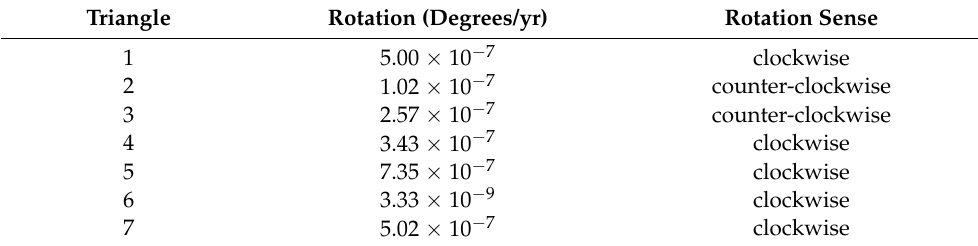
Figure 16. The post-Neogene stress and strain map of the north part of the East Iran orogen (EIO). The present-day stress and strain directions are from the stress inversion of the fault data and geodetic data, respectively. The paleo-stress data are based on [6], and the presented stress inversions of the focal mechanism (FMSI) are from [60]. The geodetic rotation rates and their sense within each triangle are calculated from the geodetic data. Table 4. The value and sense of the geodetic rotation rate in each